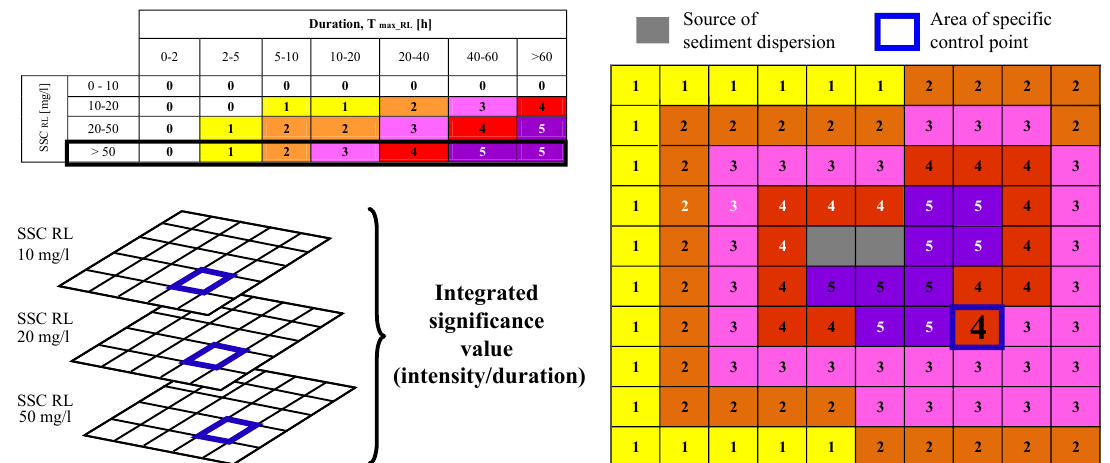
Figure 8. Example of maps of the significance of effects (based on intensity and duration) related to events of exceedance of reference levels (RLs). Significance classes are defined evaluating intensity and duration of exceedance of reference levels for increasing SSC (SSC RL = 10, 20, 50 mg/L). Final significance level is the integrated result obtained by maps overlapping (right